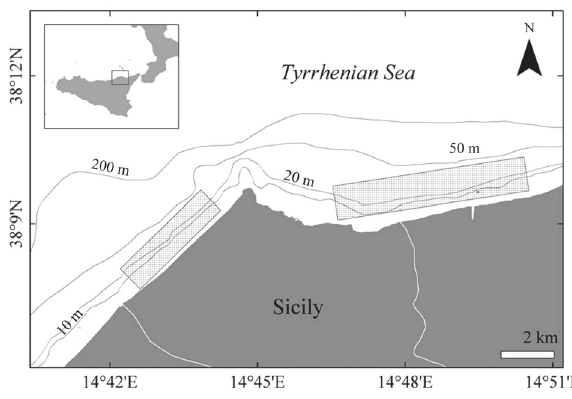
Fig . 1. – study area, showing sampling